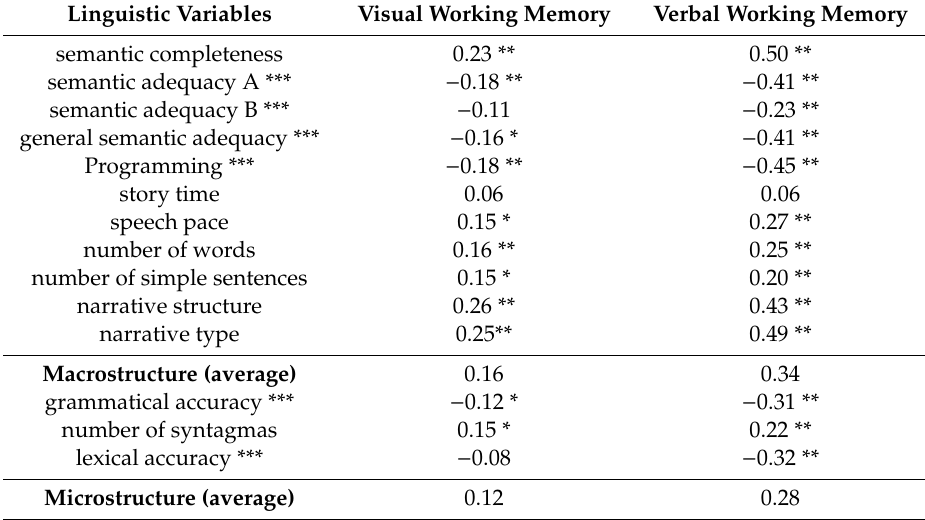
Table 1. Correlation of oral linguistic variables and working memory in preschool children (Pearson